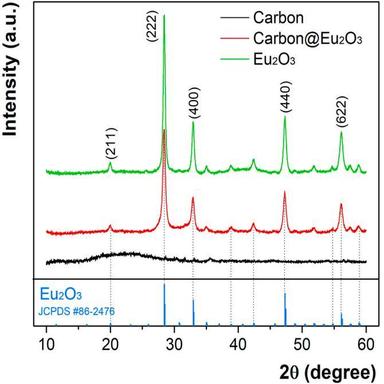
XRD patterns of carbon spheres (black line), Carbon@Eu2O3 (red line), and Eu2O3 after the thermal treatment. The standard pattern of Eu2O3 (JCPDS card #86-2476) is displayed in the figure for comparison. (For interpretation of the references to color in this figure legend, the reader is referred to the Web version of this article.)